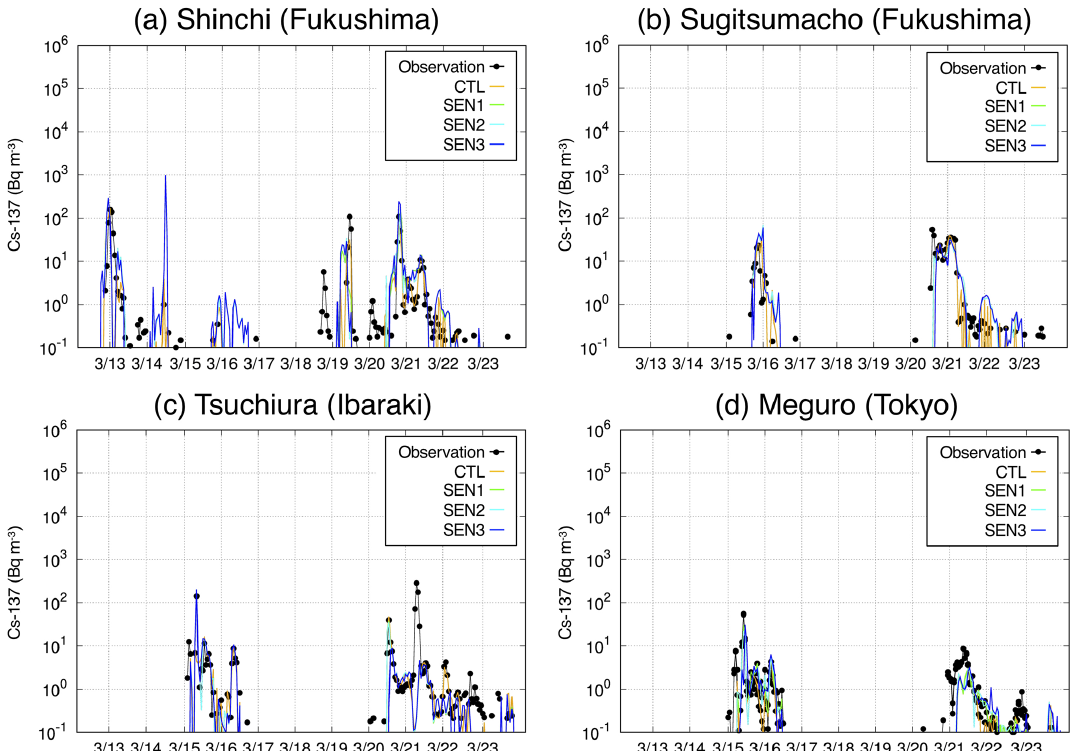
Figure 5. Temporal variations in Cs-137 at the independent sites (not learning but validation sites) using the LMVE ensemble method for CTL, SEN1, SEN2 and SEN3. The time is